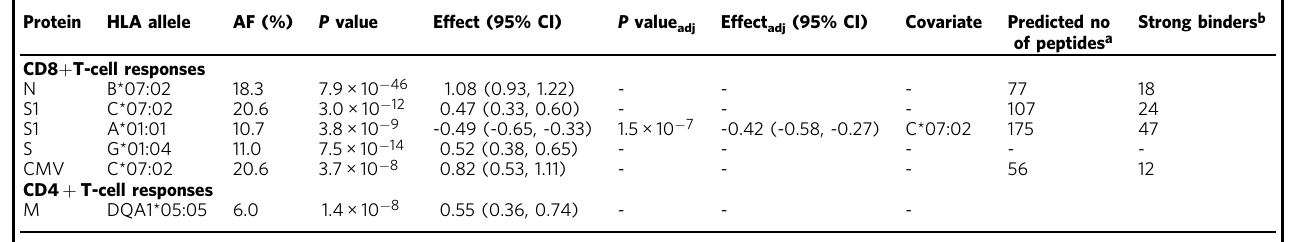
Table 2 HLA alleles associated with CD8 + and CD4 + T-cell